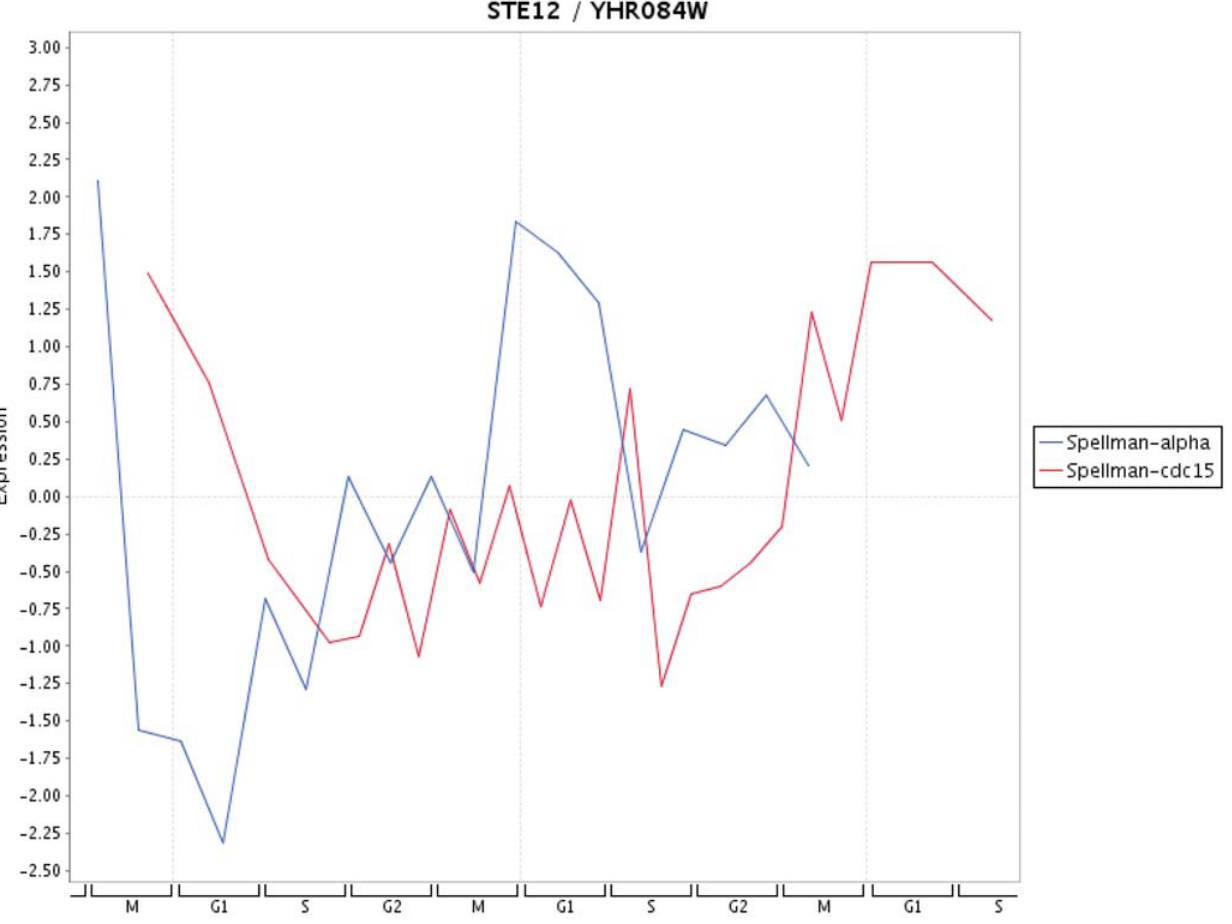
Figure 9. Expression profile for STE12 for time series data from S PELLMAN et al. [ 32 ] .